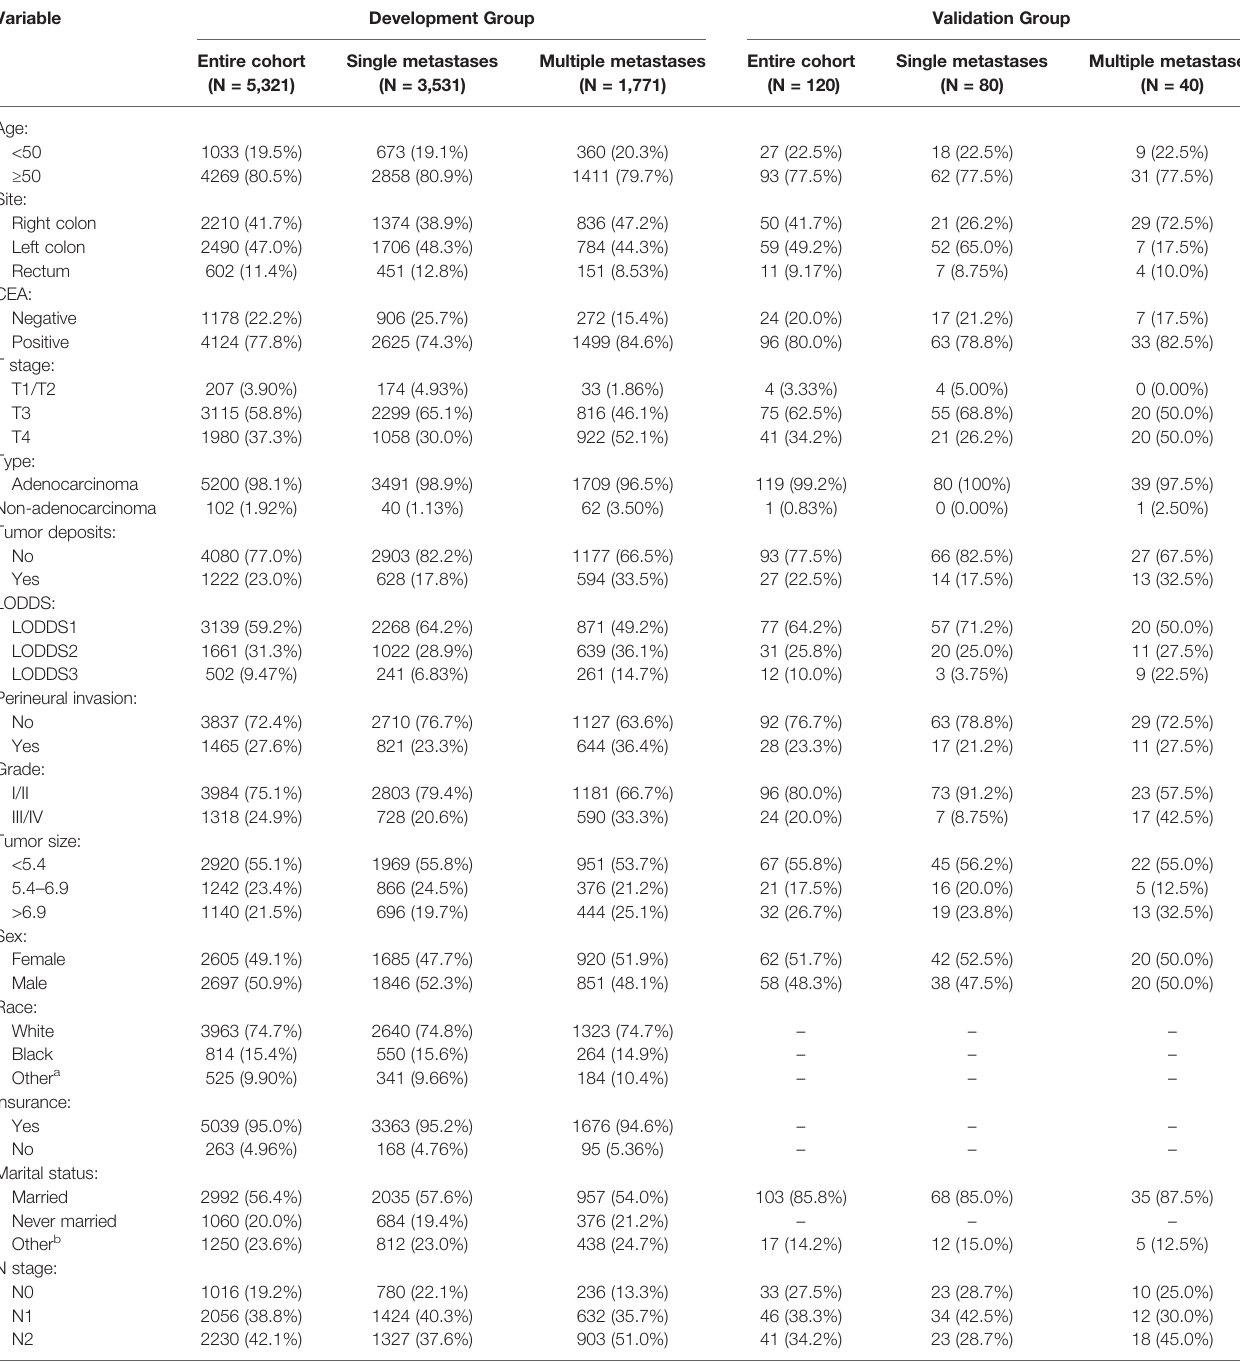
TABLE 1 | Clinical and pathological features of metastatic colorectal cancer